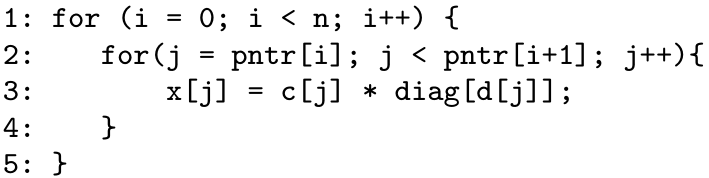
Figure 1. Subscripted subscript pattern in an example loop. The subscript expression of array x , that is j , derives its values from array pntr .